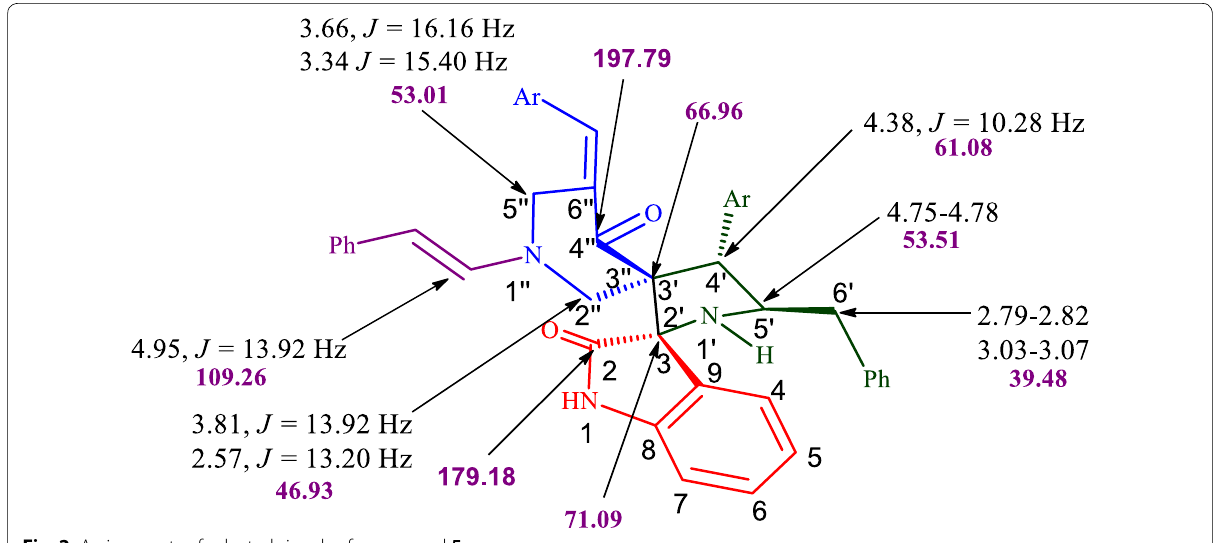
Fig. 2 Assignments of selected signals of compound